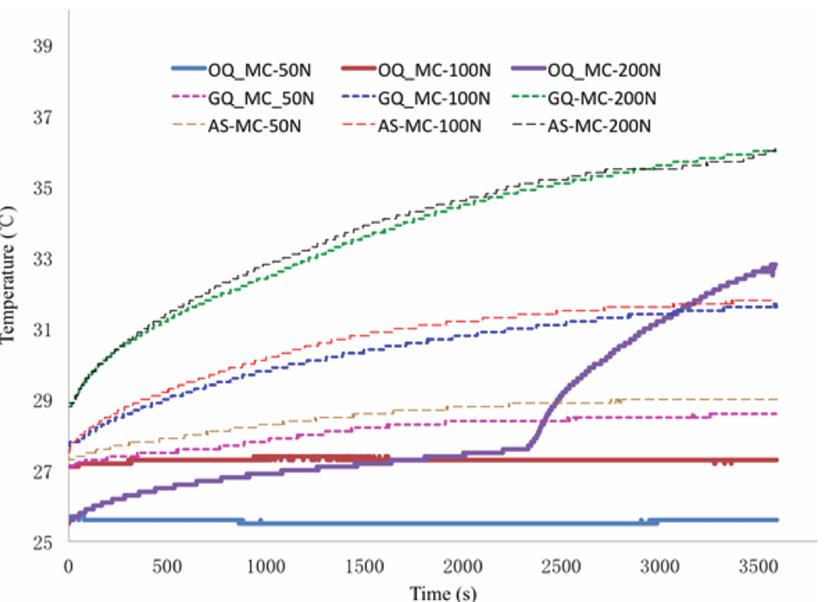
Figure 8: Temperature of bottom